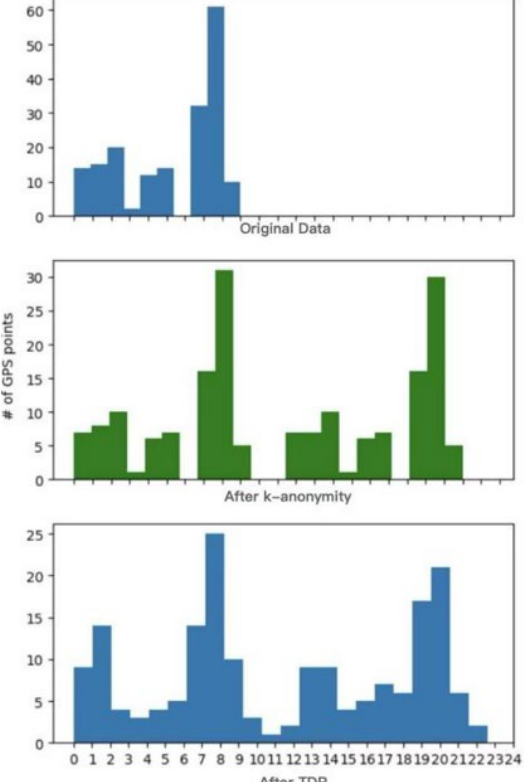
Figure 8. Diagram of time distribution after encrypting data with various algorithms for the Geolife Trajectories dataset .